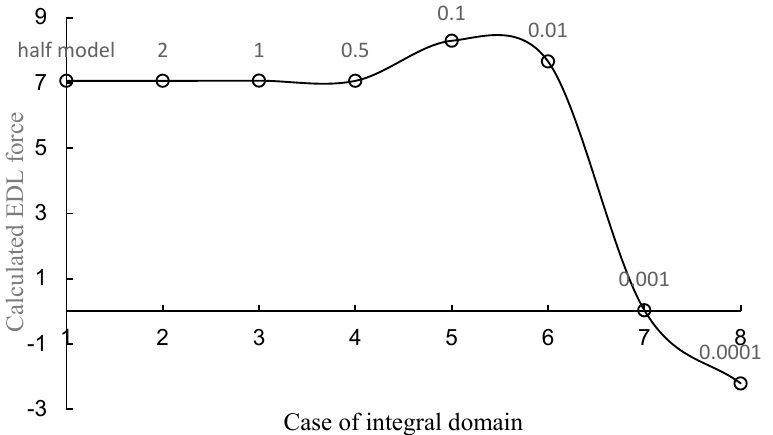
Figure 7. Calculated EDL forces for different chosen integral domain ( α = 120 ◦ , d = 1.0, and φ 0 =